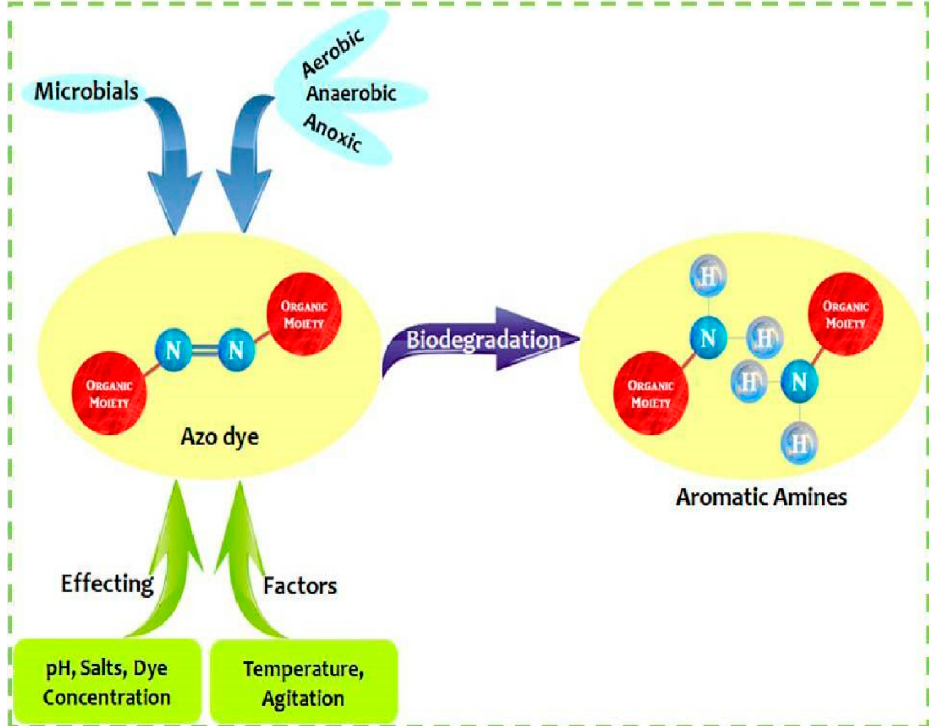
Figure 6. Basic mechanism for microbial biodegradation of azo dyes